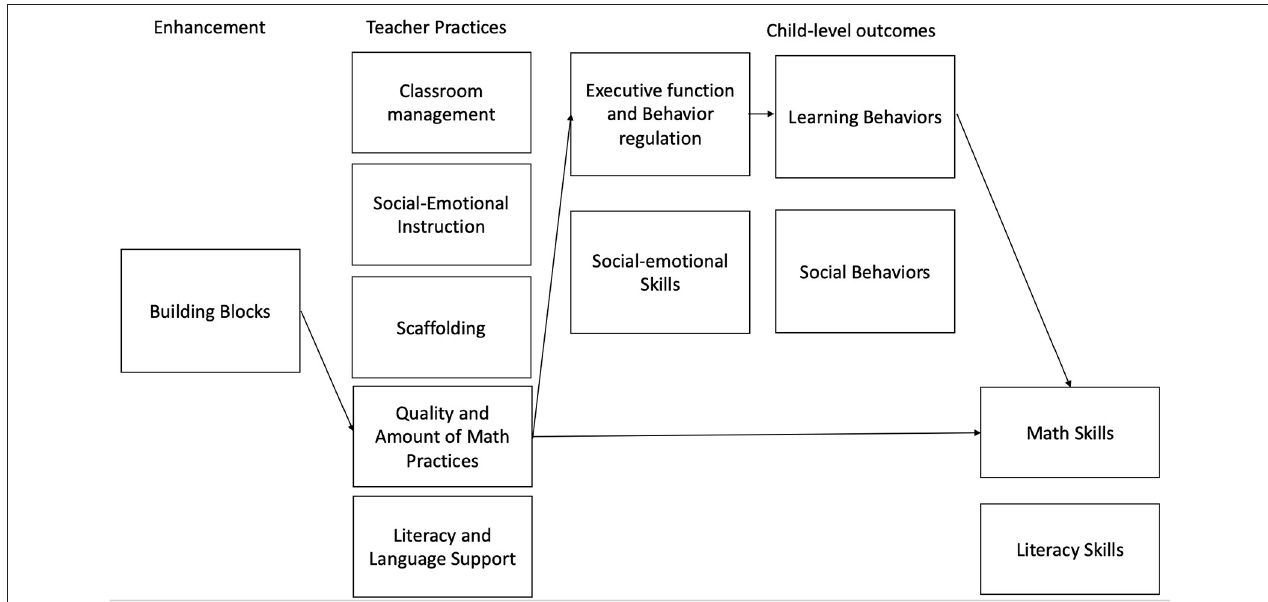
FIGURE 4 | Hypothesized theory of change for cognitive skills